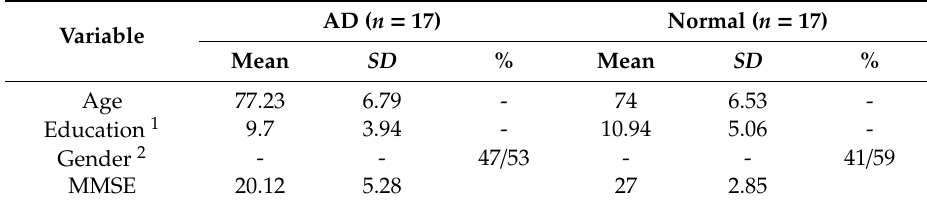
Table 1. Characteristics of the research